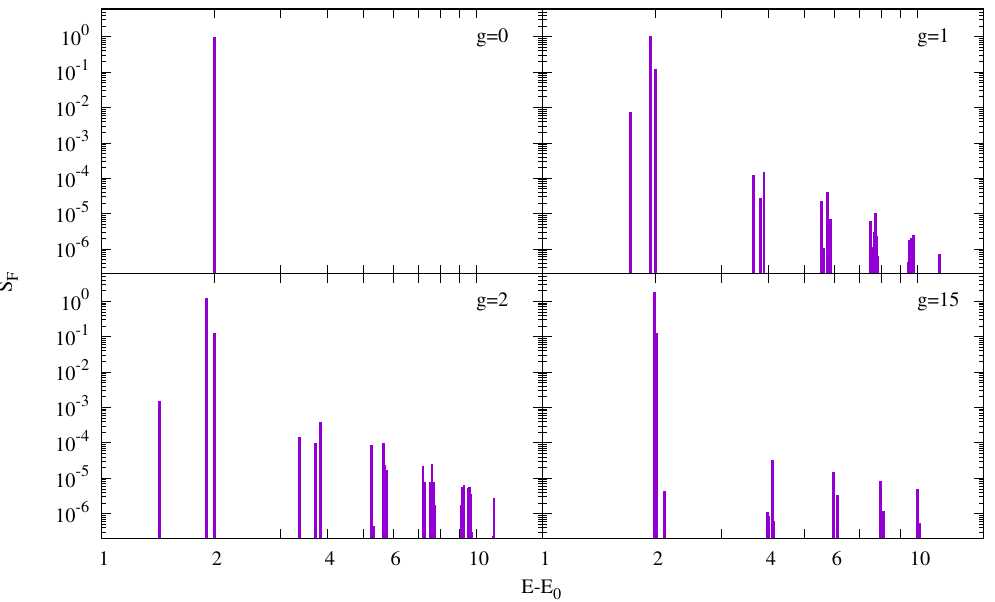
Figure 11. Dynamic structure function of a mono-polar excitation for the case of four particles. The total spin of the ground state and of all excited states connected to it through the mono-polar excitation, are zero. The different panels correspond to four different values of interaction strength. From the non-interacting case, g = 0 to a strongly interacting one g =